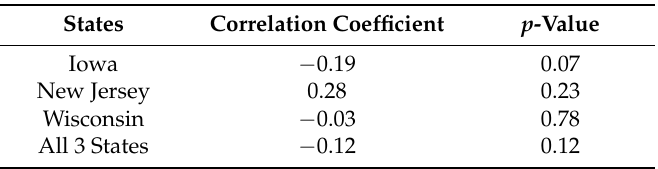
Table 1. Correlation coefficient between percent of samples >4 pCi/L and age-adjusted thyroid cancer incidence rates in county-level data from three US States. Cancer incidence 1990–2013. States Correlation Coefficient p -Value Iowa − 0.19